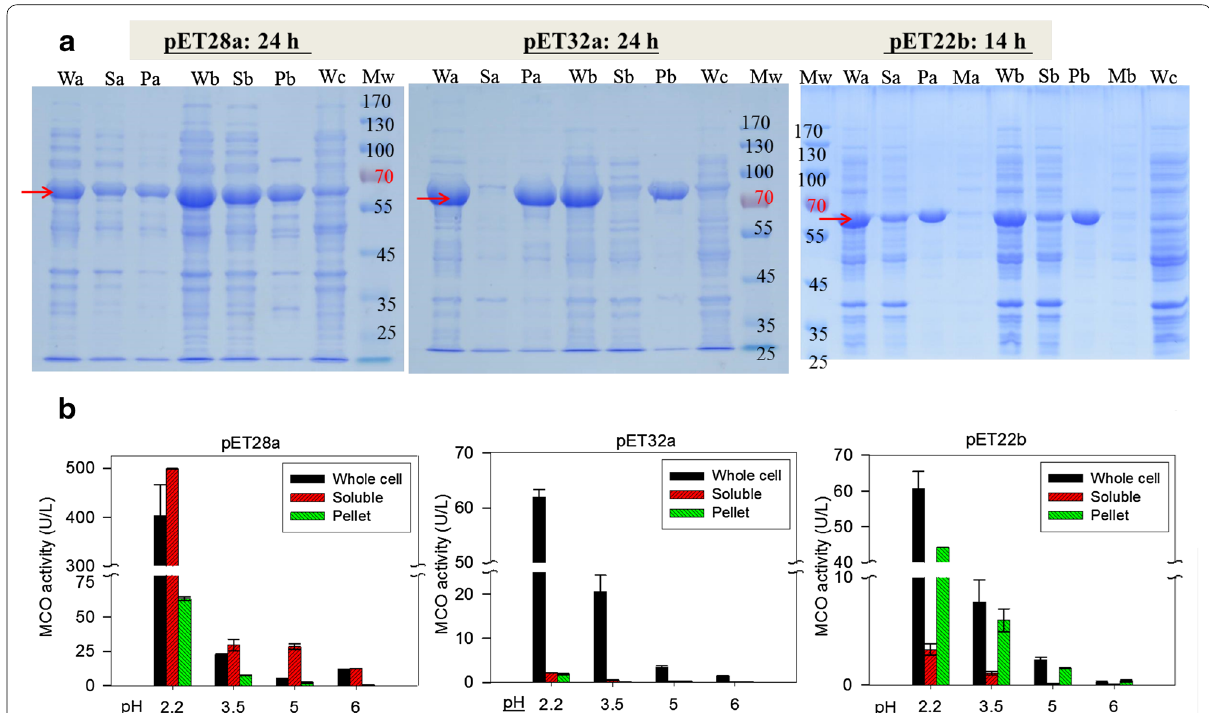
Fig. 3 a SDS‑PAGE analysis of recombinant MCO generated from ( left ) pET28a‑lacB at 24 h, ( middle ) pET32a‑lacB at 24 h, and ( right ) pET22b‑lacB at 14 h transformed in E. coli BL21(DE3) cells. Samples used are W, whole cell; S, supernatant; P, pellet; and M, periplasm; where subscript of a, b and instead of induction by IPTG with Cu, IPTG and none of them. Mw means molecular weight. The arrows indicated the overexpression of MCO. b Crude MCO activity in whole cell lysates, soluble and cell pellet from recombinant ( left ) pET28a, ( middle ) pET32a and ( right ) pET22b at different pHs